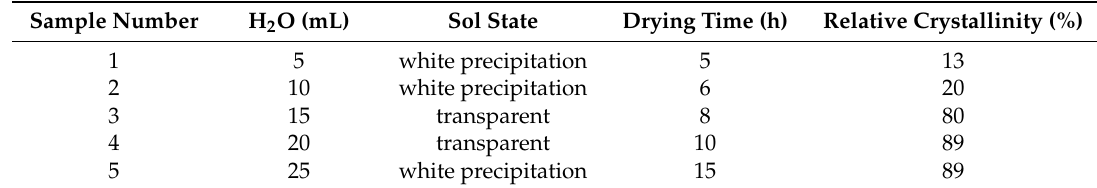
Table 2. Experimental phenomena and relative crystallization of SrTiO 3 prepared with different amounts of water.